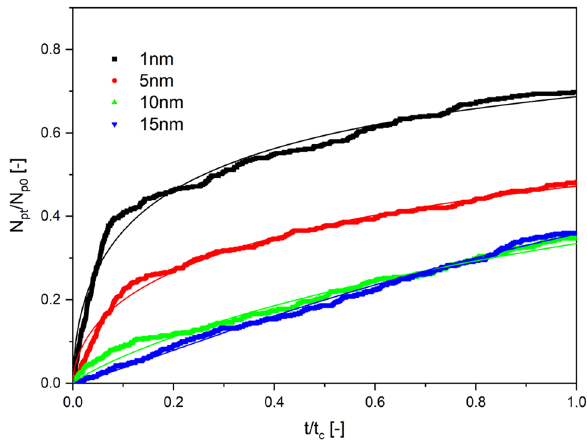
Figure 4. The dependence on the normalized number of particles as a function of normalized time. The viscosity of liquid was 10 mPa·s for particles of different diameters.